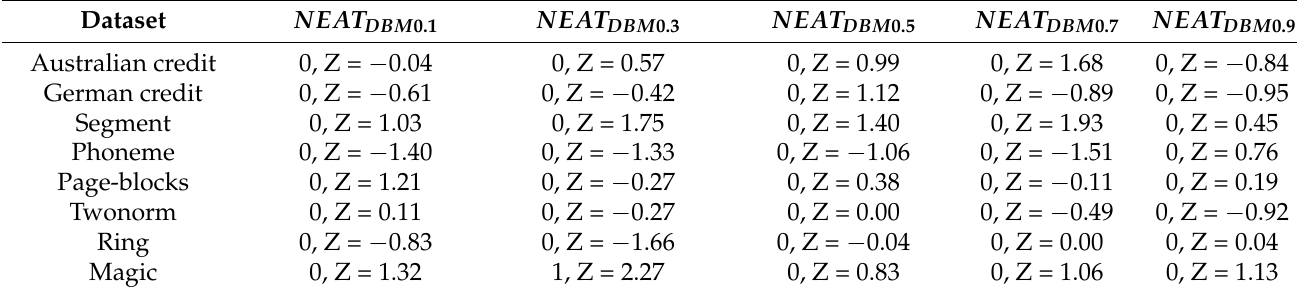
Table 6. Mann–Whitney statistical tests of NEAT-DBM compared to NEAT, test